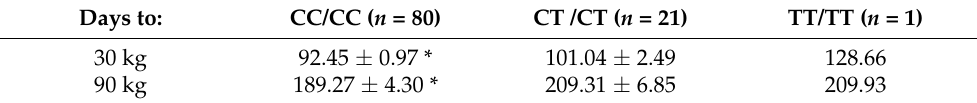
Table 2. Analysis of the effects of CC, CT, and TT genotypes of the TRPC1 gene in New Huai pigs. Days